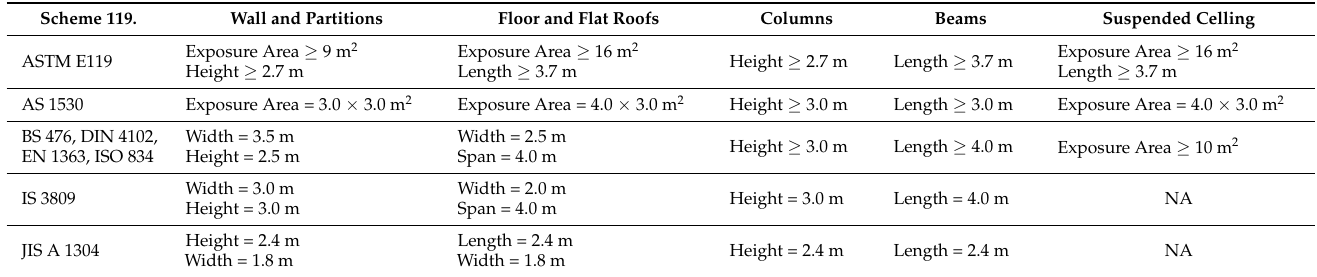
Table 6. Specimen size for fire testing according to different fire-resistance test standards.